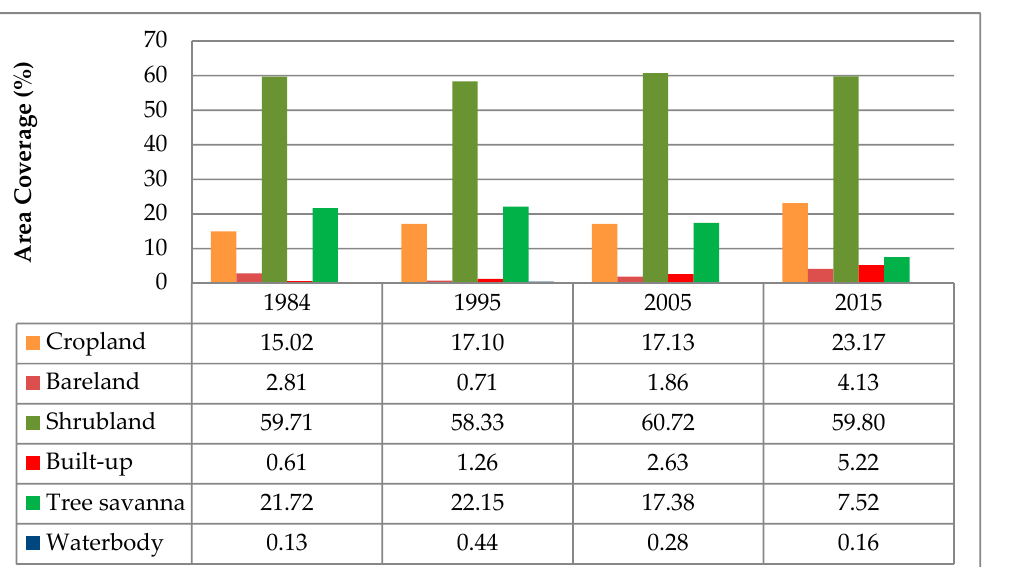
Remote Sens. 2021 , 13 , x FOR PEER REVIEW 12 of 22